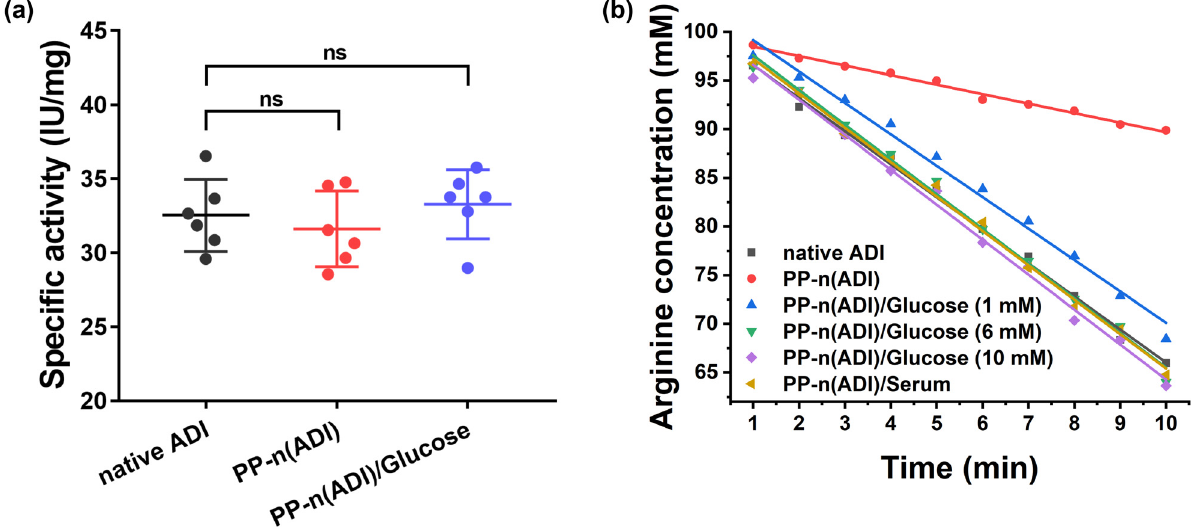
Figure 4: ( a ) The measurement of the speci fi c activities of samples. The signi fi cance level was ns p > 0.05. ( b ) Arg was incubated with di ff erent samples and its concentration change in 10 min was